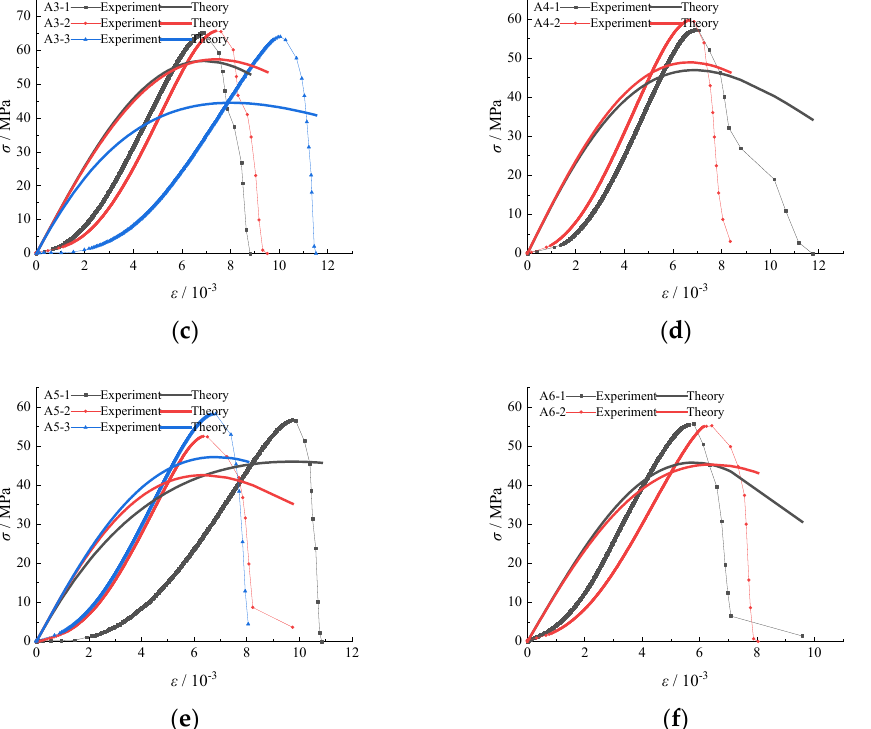
Figure 9. The stress-strain experimental curves and theoretical damage curves of sandrock contain- ing water under uniaxial compression status. ( a ) Dry Sample; ( b ) Sample Submerged for 0.75 h; ( c ) Sample Submerged for 1.5 h; ( d ) Sample Submerged for 6 h; ( e ) Sample Submerged for 24 h; ( f ) Sample Submerged for 720 h. (2) Conventional Triaxial Compression Status Table 4. Value of m 2 under triaxial compression status.